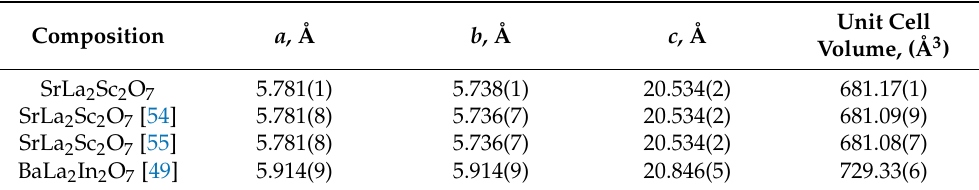
Table 1. The lattice parameters and unit cell volumes of the compositions SrLa 2 Sc 2 O 7 and BaLa 2 In 2 O 7 .